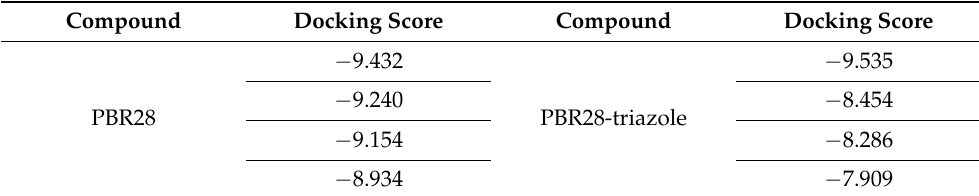
Table 1. Glide docking scores were obtained with Maestro for the top four poses of each ligand docked on